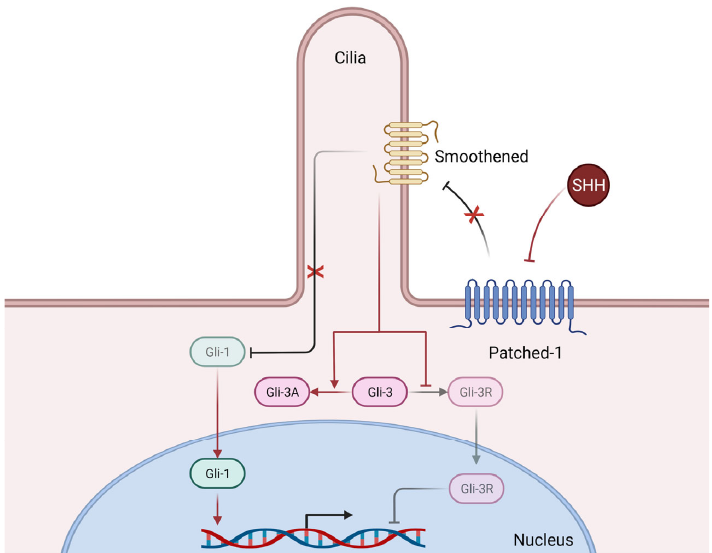
Figure 3. Simplified mechanisms of canonical Hedgehog signaling. Briefly, Sonic Hedgehog (SHH) binds to its receptor Patched ‐ 1 thus releasing its inhibition of Smoothened, whose activation in turn releases the previously inhibited Gli ‐ 1 transcription factor, who can then translocate to the nucleus and induce the transcription of numerous genes. Furthermore, releasing the inhibition of Smooth ‐ ened also promotes the expression of the Gli ‐ 3 transcription factor in its activator form (Gli ‐ 3A) which can then translocate to the nucleus and exert its transcriptional activity (not shown here), whereas in basal conditions (i.e., without SHH), the repressor form (Gli ‐ 3R) is the predominantly active form. Of note, Smoothened requires functional primary cilia architecture for functional Hedgehog signaling